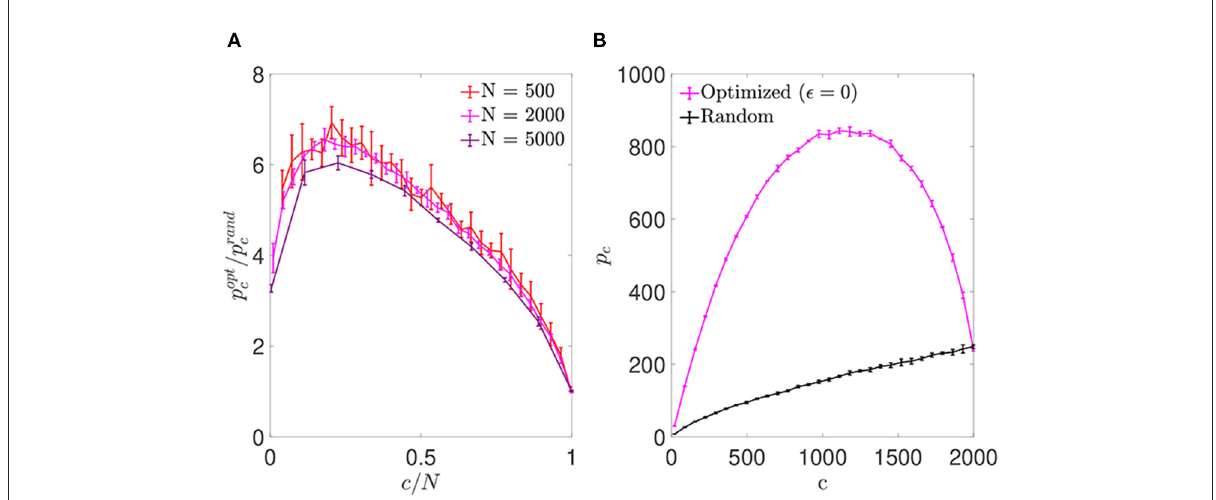
FIGURE1 Networks optimized by noise reduction outperform randomly connected ones in terms of storage capacity. (A) Ratio between the storage capacity for optimized ( p opt c ) and random ( p rand c ) connectivity as a function of the number of connections per neuron for networks of different N (color coded; mean ± s.d.). (B) Overall maximum number of patterns (not normalized by c ) that can be stored and retrieved in an optimized (magenta) or random (black) network of N = 2,000 as a function of c (mean ± s.d.). Note that the maxima for p opt c / p rand c (A) and p opt c (B) occur for different connectivity levels, implying that more patterns can be stored using a higher number of less efficient connections. Pool of data corresponding to five simulations for each